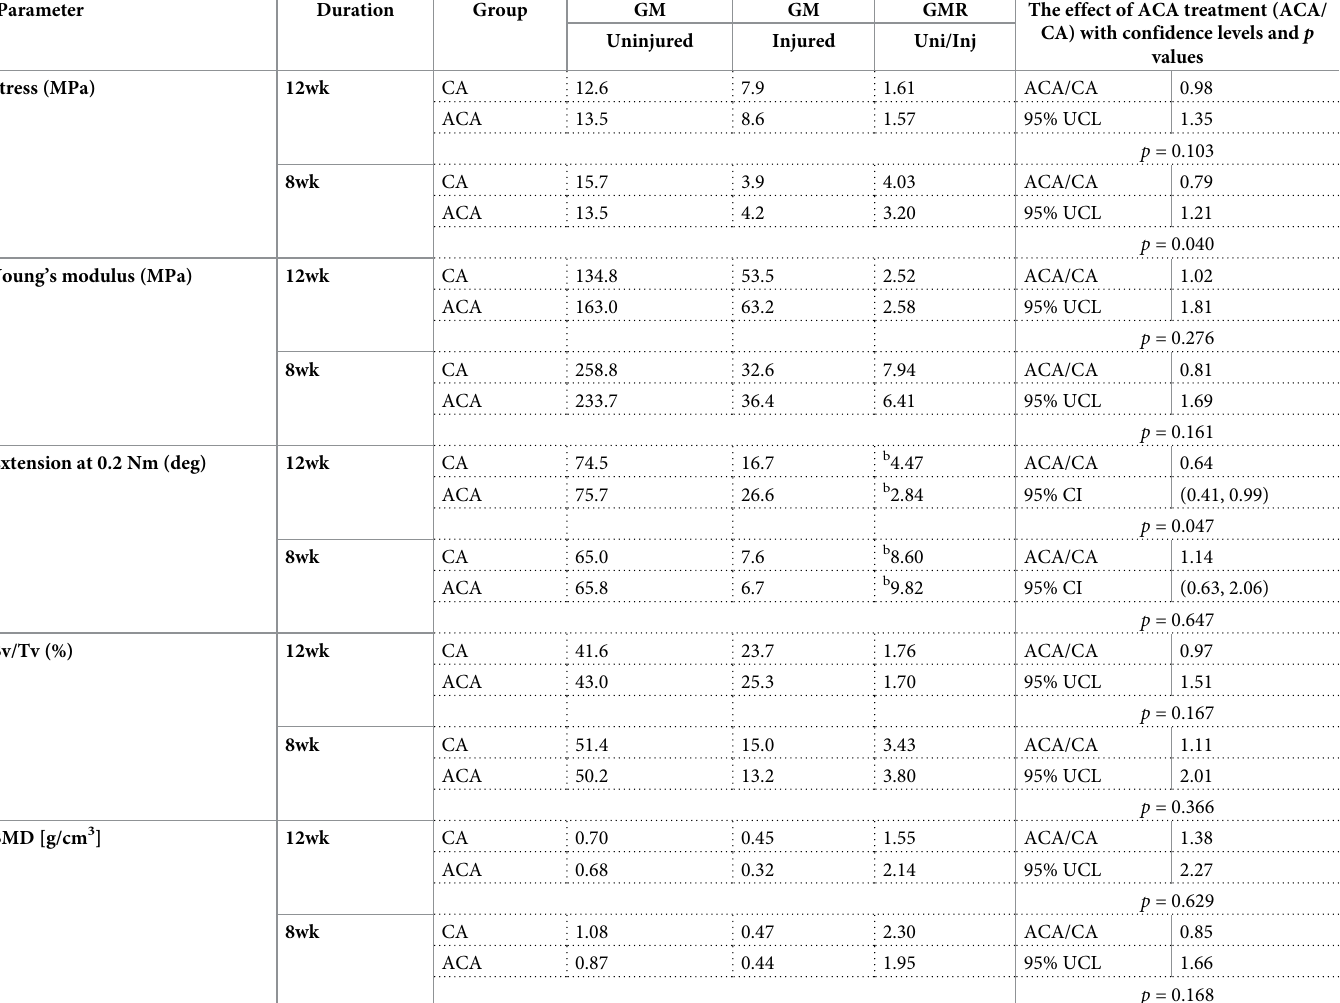
Table 7. Summaries of tests to determine the ACA’s effects on the flexion contracture and parameters defining the quality of healing of the PTs (stress and Young’s modulus) and subchondral bone defects (Bv/Tv and BMD) a